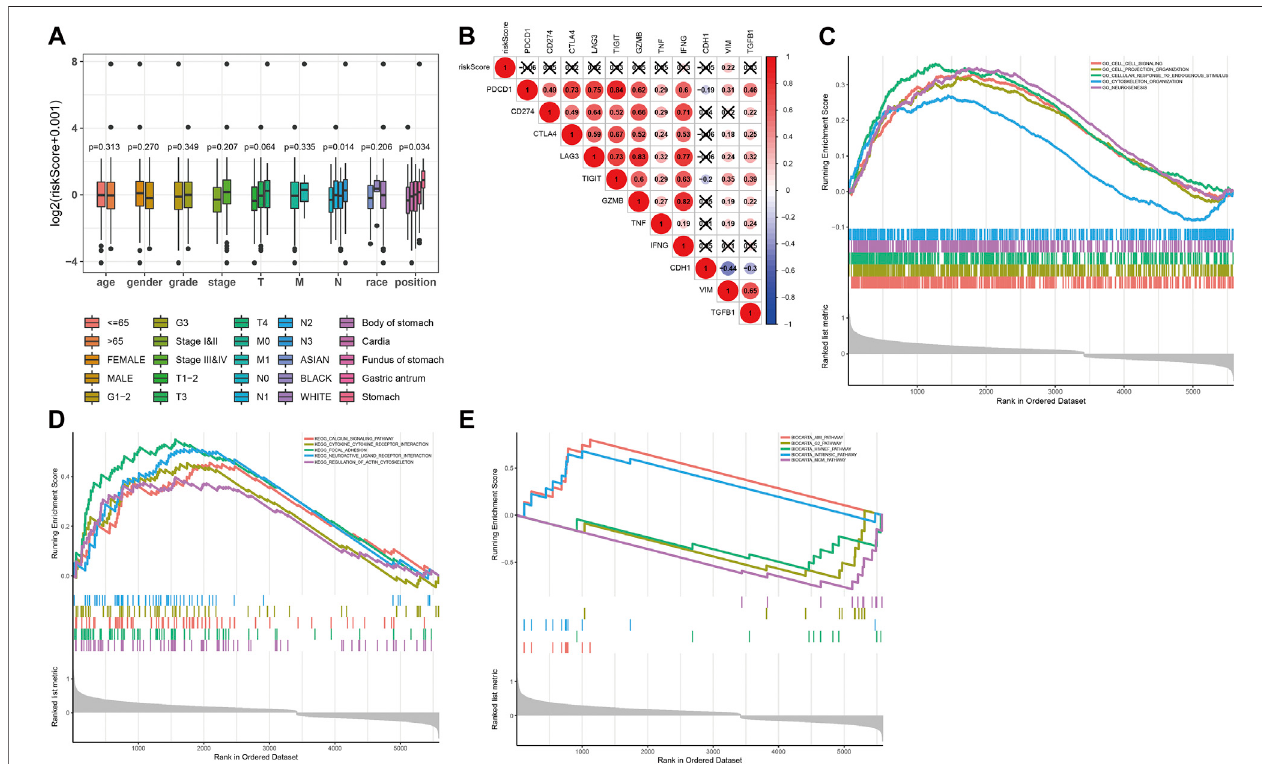
FIGURE 7 | Functional analysis of prognostic risk score. (A) Correlation analysis between prognostic risk score and age, gender, tumor grade, N stage, T stage, race,andtumor location ofthepatient intheprognosticriskmodel. (B) Correlation analysisbetweenprognosticriskscoreandexpression levelsofregulatory,cytotoxic, and epithelial – mesenchymal transition (EMT) factors of immune checkpoint sites. (C – E) The results of gene set enrichment analysis on the potential mechanism of c5 (c5.bp.v7.1.entrez.gmt) and c2 (c2.cp.kegg.v7.1.entrez.gmt, c2.cp.biocarta.v7.1.entrez.gmt) in the molecular signatures